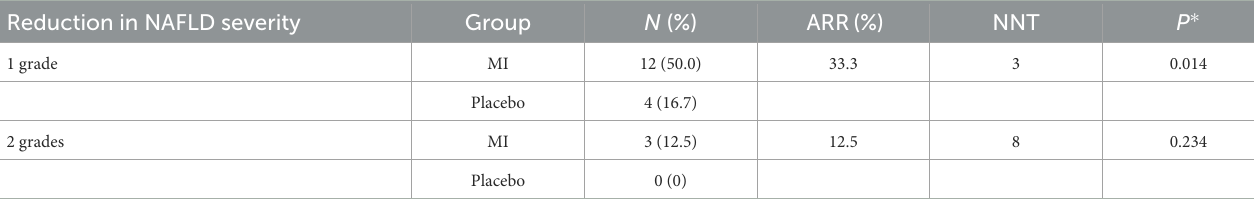
TABLE 4 Effectiveness level for reduction in steatosis severity. Reduction in NAFLD